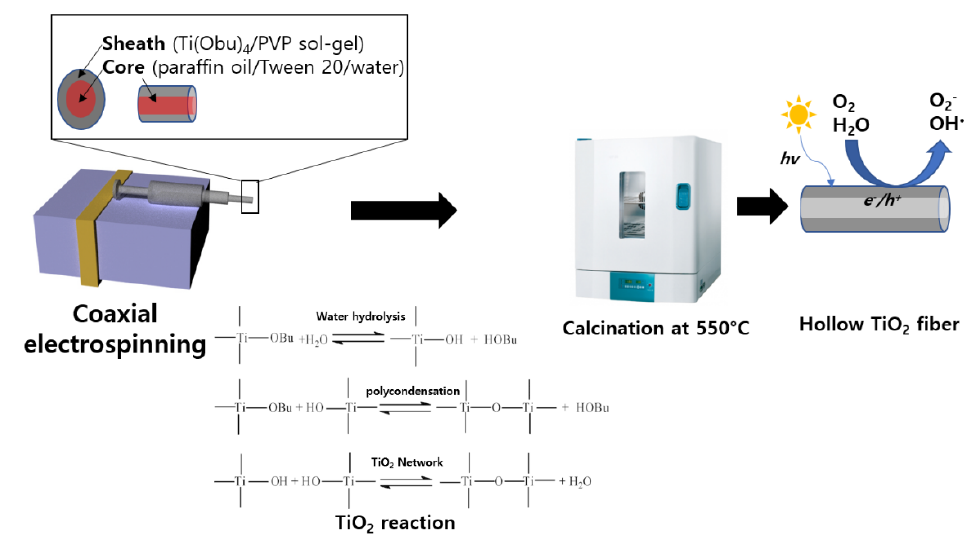
Figure 1. Fabrication method of hollow TiO 2 fibers via coaxial electrospinning and their reactions for the hydrolysis process with titanium butoxide as a precursor.